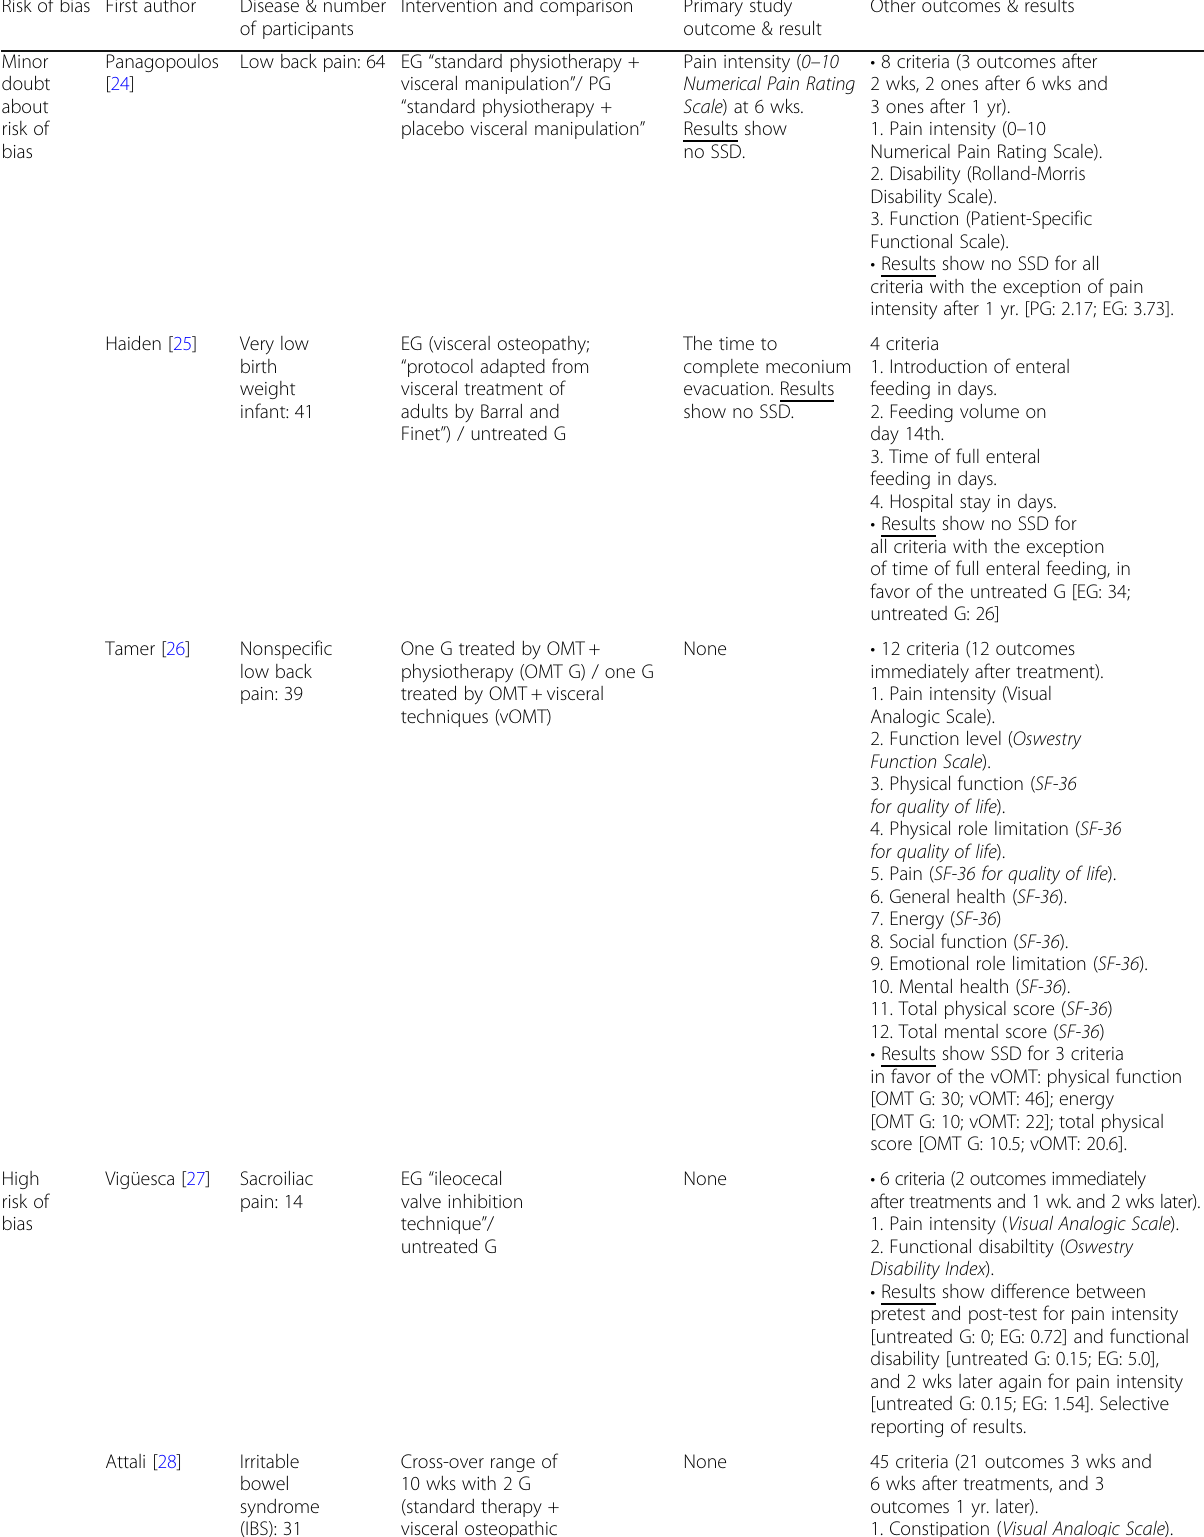
Table 2 Description of included studies dealing with the clinical efficacy of techniques used in visceral osteopathy Risk of bias First